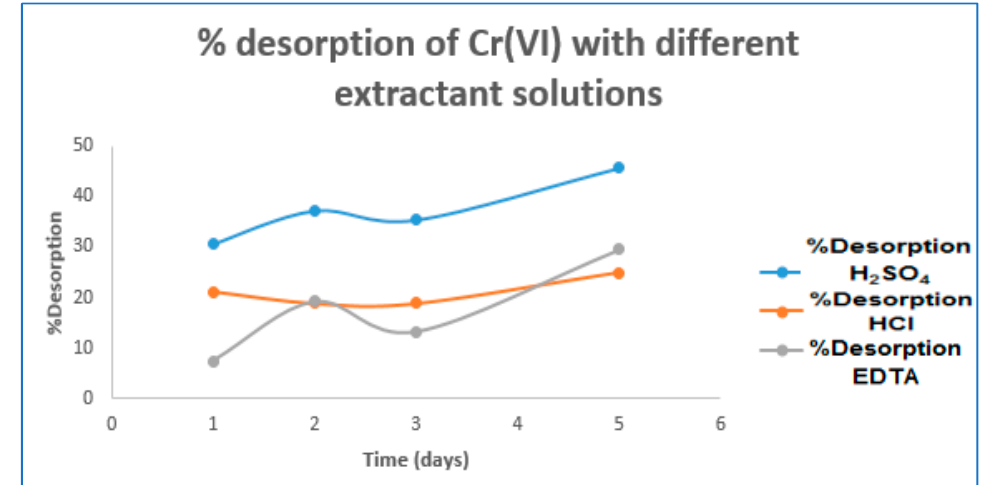
Figure 3. Percentage desorption of Cr(VI) with different extractant solutions.